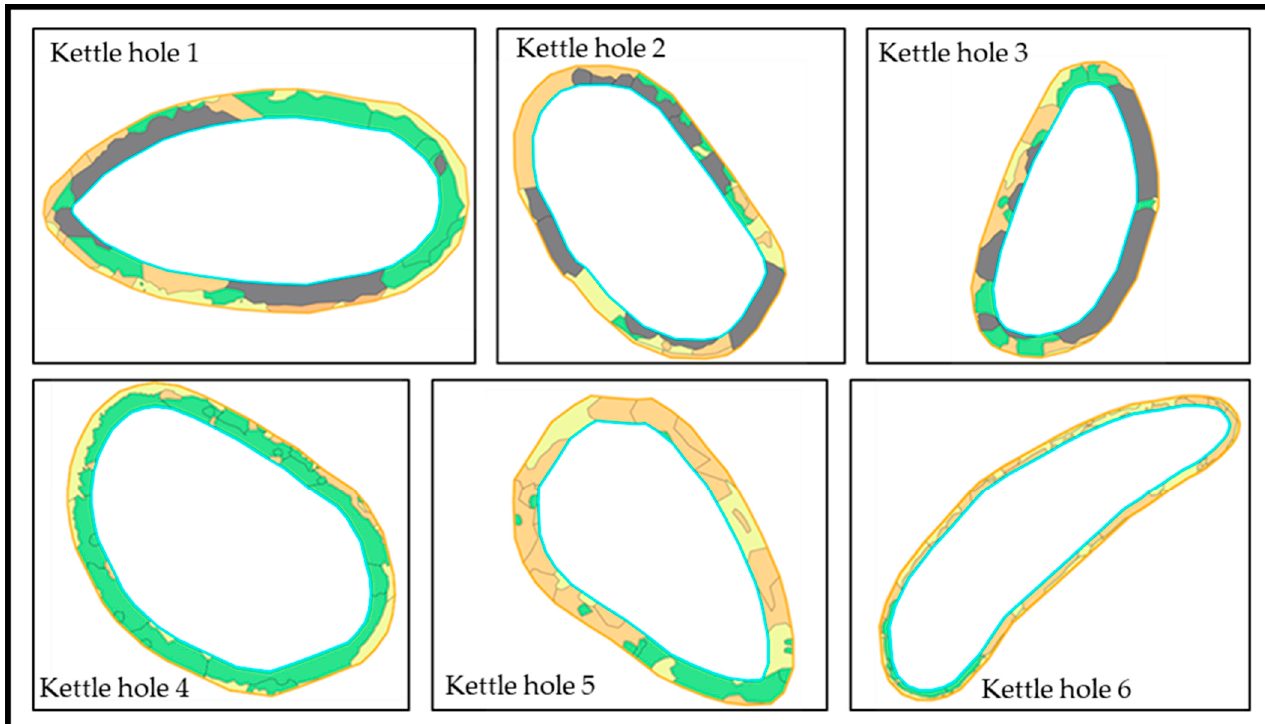
Figure 7. Digitalized vegetation at the edges of six different kettles holes investigated in 2019/2020 (exemplary). Different plant species were digitalized based on orthomosaics via manually mapping in QGIS. Green color, herbaceous plants; yellow color, Poaceae ; orange color, mixture of herbaceous plants/ Poaceae ; grey color, woody plants .